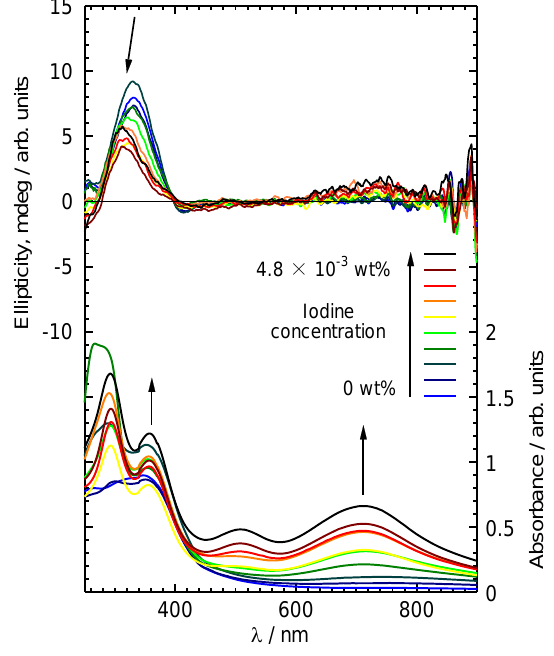
Figure 4. CD and UV-vis absorption spectra of ME1 in CHCl doping